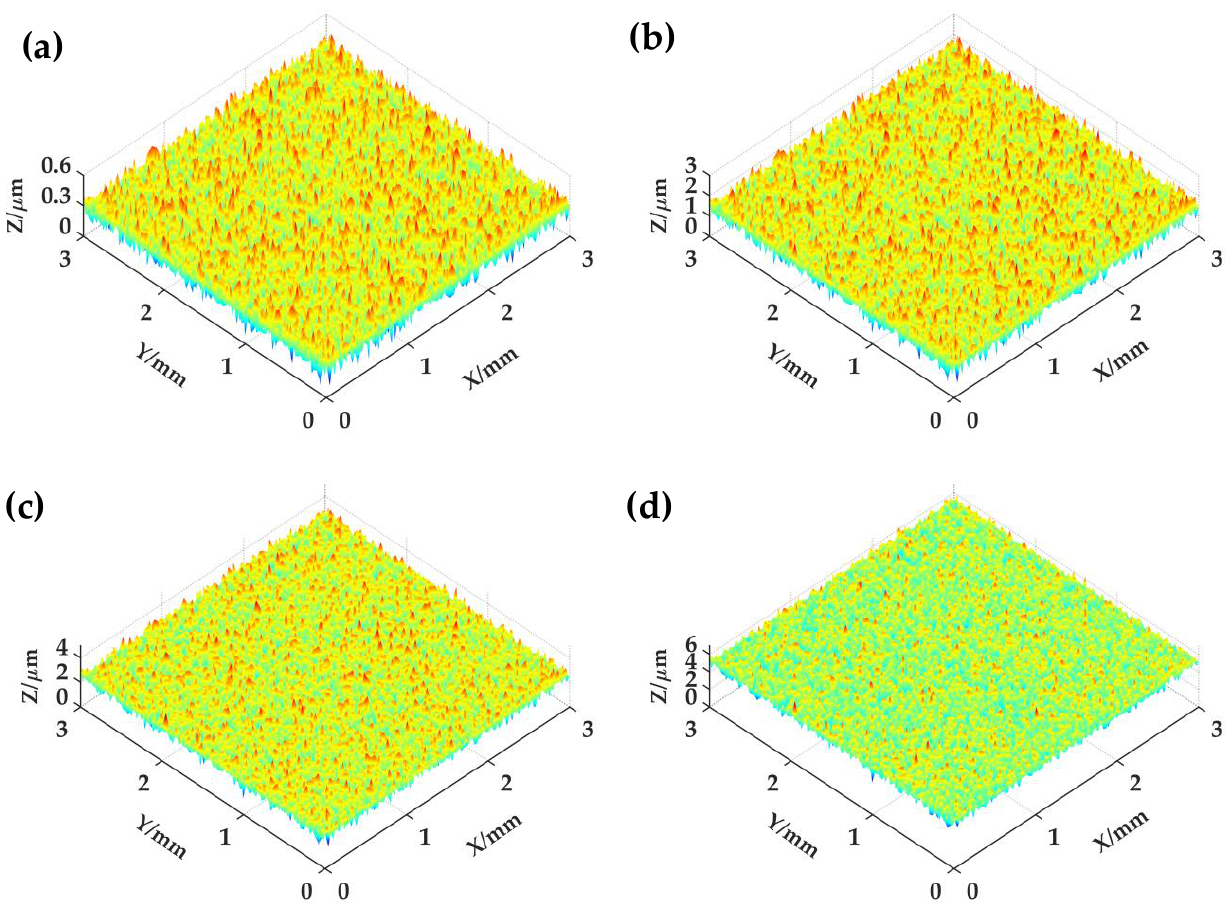
Table 1. The fractal characteristic parameters of different grinding surfaces.